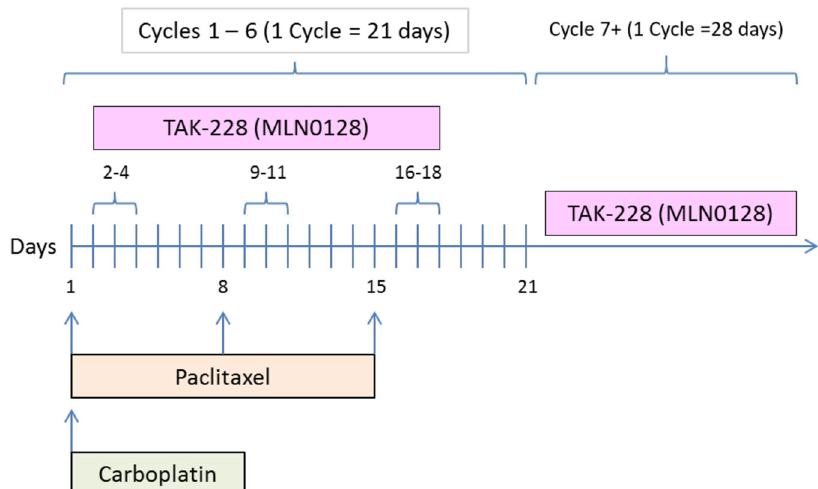
Fig. 5 Trial schema (NCT03430882). Patients were treated with as many as six, 21-day cycles of the combination regimen. The regimen is comprised of carboplatin AUC 5 intravenously every 3 weeks on Day 1 of each cycle plus sapanisertib (TAK-228 or MLN0128) daily on Day 2 – 4 of each week at 2 mg, 3 mg and 4 mg orally and paclitaxel 40 mg/m2, 60 mg/m2, 80 mg/m2 QW IV on Day 1, 8, and 15 of each cycle. Evaluation of the composite toxicity/ef fi cacy endpoint was done at Day 21 of treatment. After the 6 cycles were completed, patients were treated to progression with sapanisertib 3 mg PO